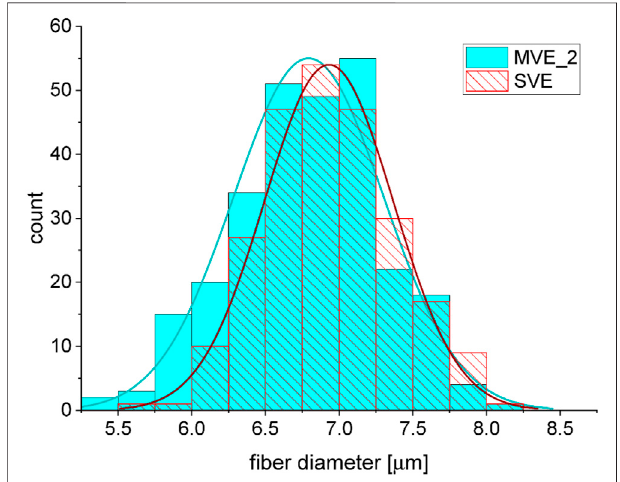
FIGURE 6 | Fiber diameter distribution of MVE of Figure 3B compared to an SVE with 40% fi ber volume fraction.